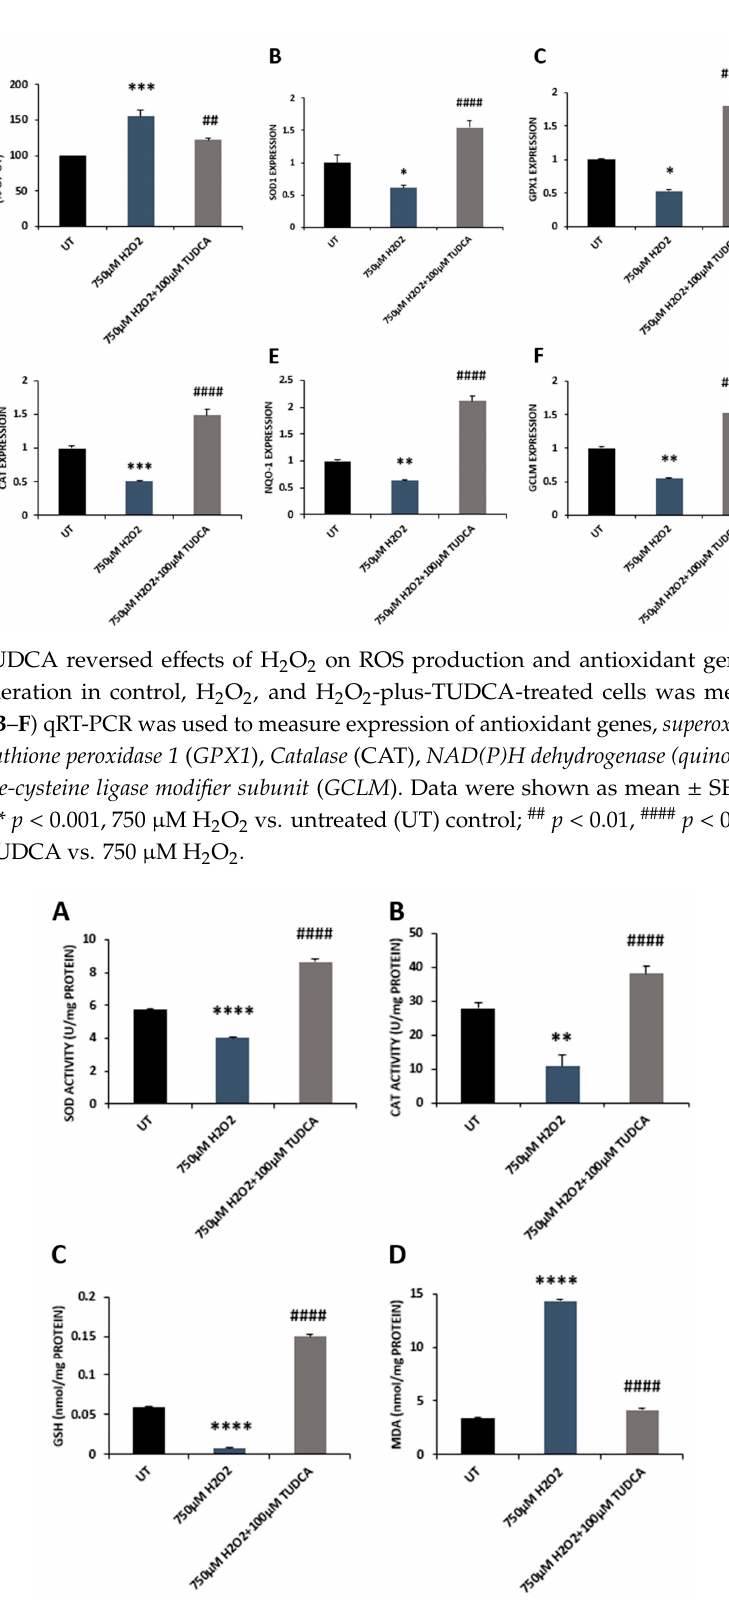
Figure 4. TUDCA counteracted H 2 O 2 -induced effects on activities of superoxide dismutase (SOD) ( A ) and catalase ( B ) and levels of glutathione (GSH) ( C ) and malondialdehyde (MDA) ( D ). Data are shown as mean ± SEM. CAT, catalase; UT, untreated (UT) control cells. ** p < 0.01, **** p < 0.0001, 750 µM H 2 O 2 vs. UT; #### p < 0.0001, 750 µM H 2 O 2 plus TUDCA vs. 750 µM H 2 O 2 . Glutathione (GSH) plays an important role in reducing the oxidative damage in cells. We measured GSH levels in control, H 2 O 2 , and H 2 O 2 -plus-TUDCA-treated cells and found that GSH level was significantly decreased in H 2 O 2 -treated cells compared to control cells; the level of GSH in co- treated cells was significantly increased compared to cells treated with H 2 O 2 only (Figure 4C). We also examined the level of malondialdehyde (MDA), a marker for oxidative stress, and found that cells incubated with H 2 O 2 showed a significant increase in MDA compared to control cells; cells co- incubated with TUDCA exhibited a significant decrease in MDA compared to cells treated with H 2 O 2 alone (Figure 4D). The nuclear factor erythroid 2–related factor 2 (NRF2) plays an important defensive role against oxidative stress by upregulating antioxidant gene expression [20]. We used qRT-PCR to measure NRF2 in control and treated cells. Cells exposed to H 2 O 2 had a significant decrease in NRF2 compared to control cells; in cells treated with TUDCA plus H 2 O 2, NRF2 was significantly increased compared to that of cells treated with H 2 O 2 only (Figure S1). 3.3. TUDCA Inhibited H 2 O 2 -induced Expression of Proinflammatory Cytokines in RPE Cells Inflammation has been implicated in the pathogenesis of inherited and complex retinal diseases [21]. There is a strong interrelationship between oxidative stress and inflammation [22]. We examined